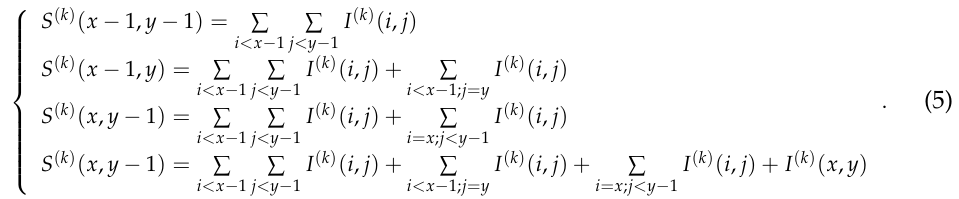
Figure 3. The relationship between the speckle distribution and integral